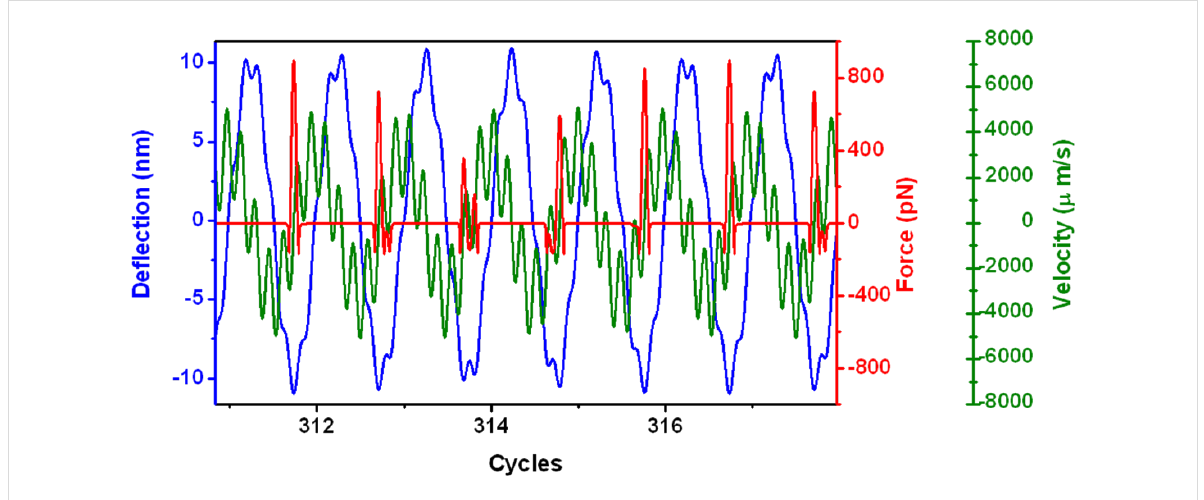
Figure 6: Bimodal AFM tip motion. The tip oscillation (blue), instantaneous force (red) and velocity (green) are shown. Notice that in this particular case the period of the oscillation is 6 times the period of the first mode. Data obtained at z c = 9 nm.